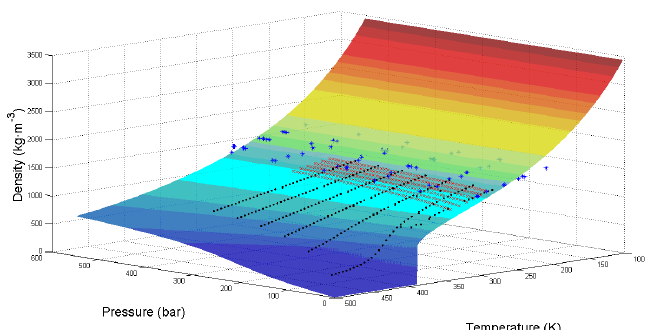
Figure 3. Theoretical calculated surface and experimental densities of R227ea. The surface represents the theoretical calculated results by Equations (1)–(9); black points represent the experimental results from Fedele et al. [1]; red crosses represent the experimental results from Ihmels et al. [24]; blue asterisks represent the experimental results from Klomfar et al. [25].